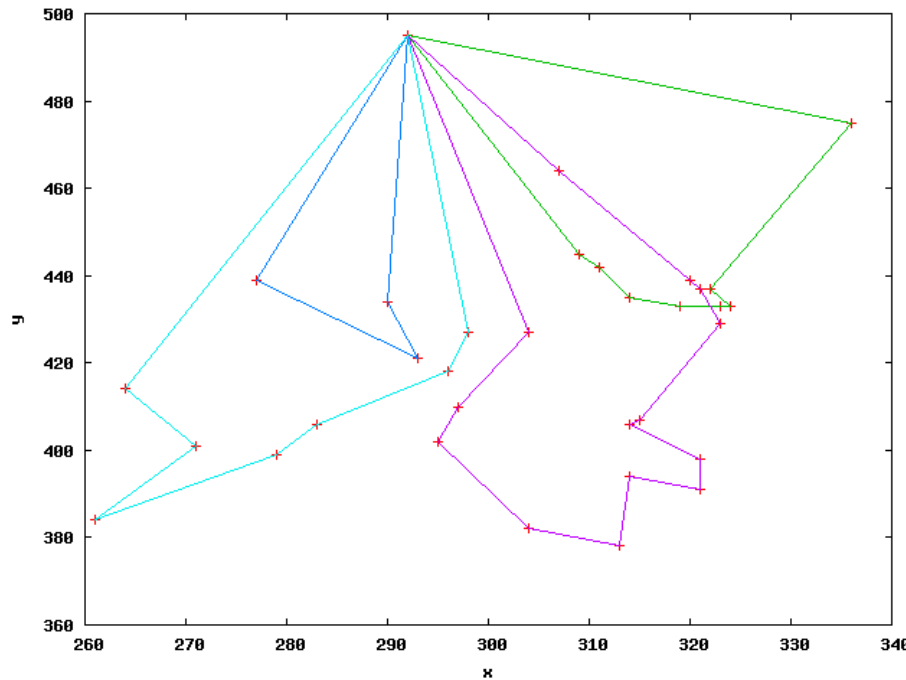
Figure 13. Crossover domination experiment—example for medium Christophides and Eilon set E, fitness distance from the best-known one around